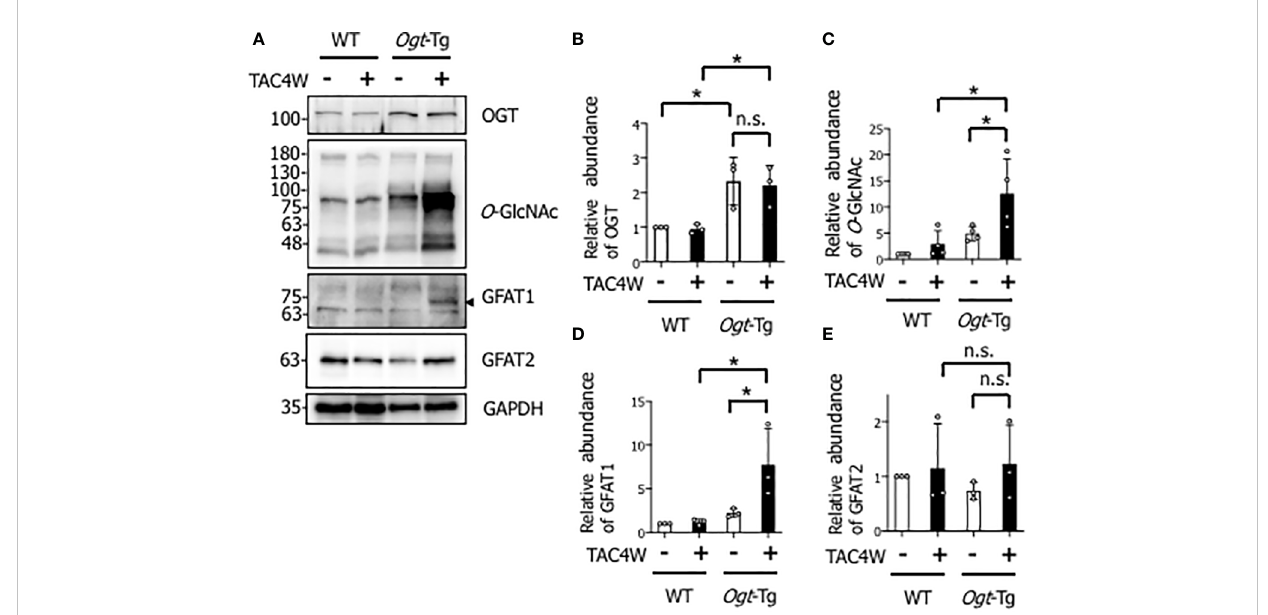
FIGURE 1 Increased O-GlcNAcylation in the hearts of Ogt-Tg mice four weeks after TAC (TAC4W). (A) Western blot analysis for OGT, O-GlcNAc, GFAT1, and GFAT2 in heart tissues from WT and Ogt-Tg mice with or without TAC4W. Representative data was designated. (B – E) Quanti fi cations of OGT, O- GlcNAc, GFAT1, and GFAT2 levels in (A) from 3 independent experiments using ImageJ software. The data were evaluated by two-way analysis of variance (ANOVA) followed by Tukey ’ s test. Values are shown as mean ± SD (*P<0.05). n.s., not signi fi cant; TAC, transverse aortic constriction; GFAT, glutamine-fructose-6-phosphate